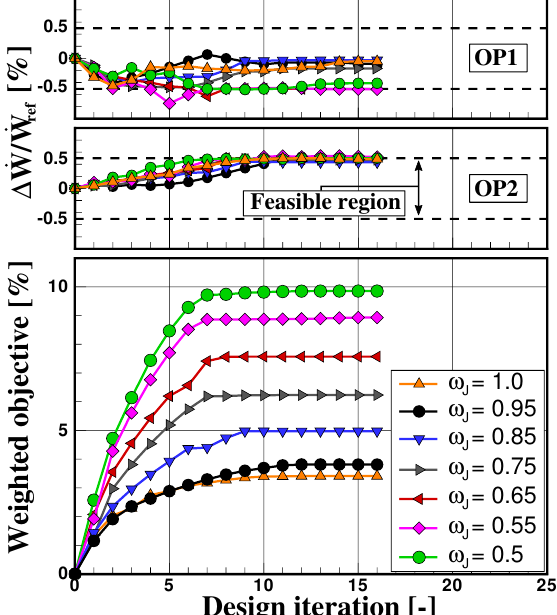
Figure 3. Optimization history of the weighted objective function ( bottom ). Evolution of the power constraints at operating points OP1 and OP2 ( top ). In total, seven optimization runs using different weights ω J are shown.